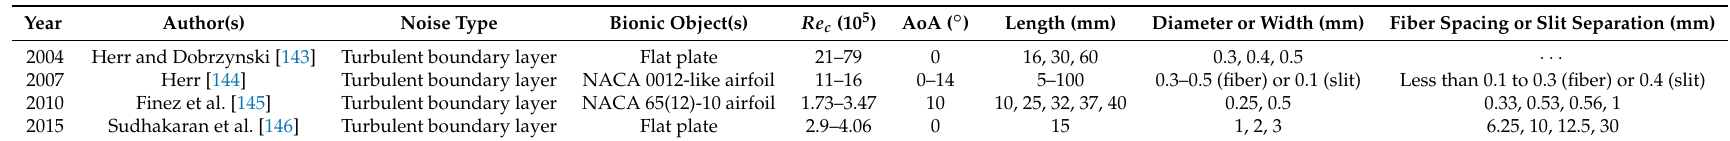
Table 7. Selected investigations of acoustic effect of fringe-type trailing edge extensions (“ · · · ” denotes “not